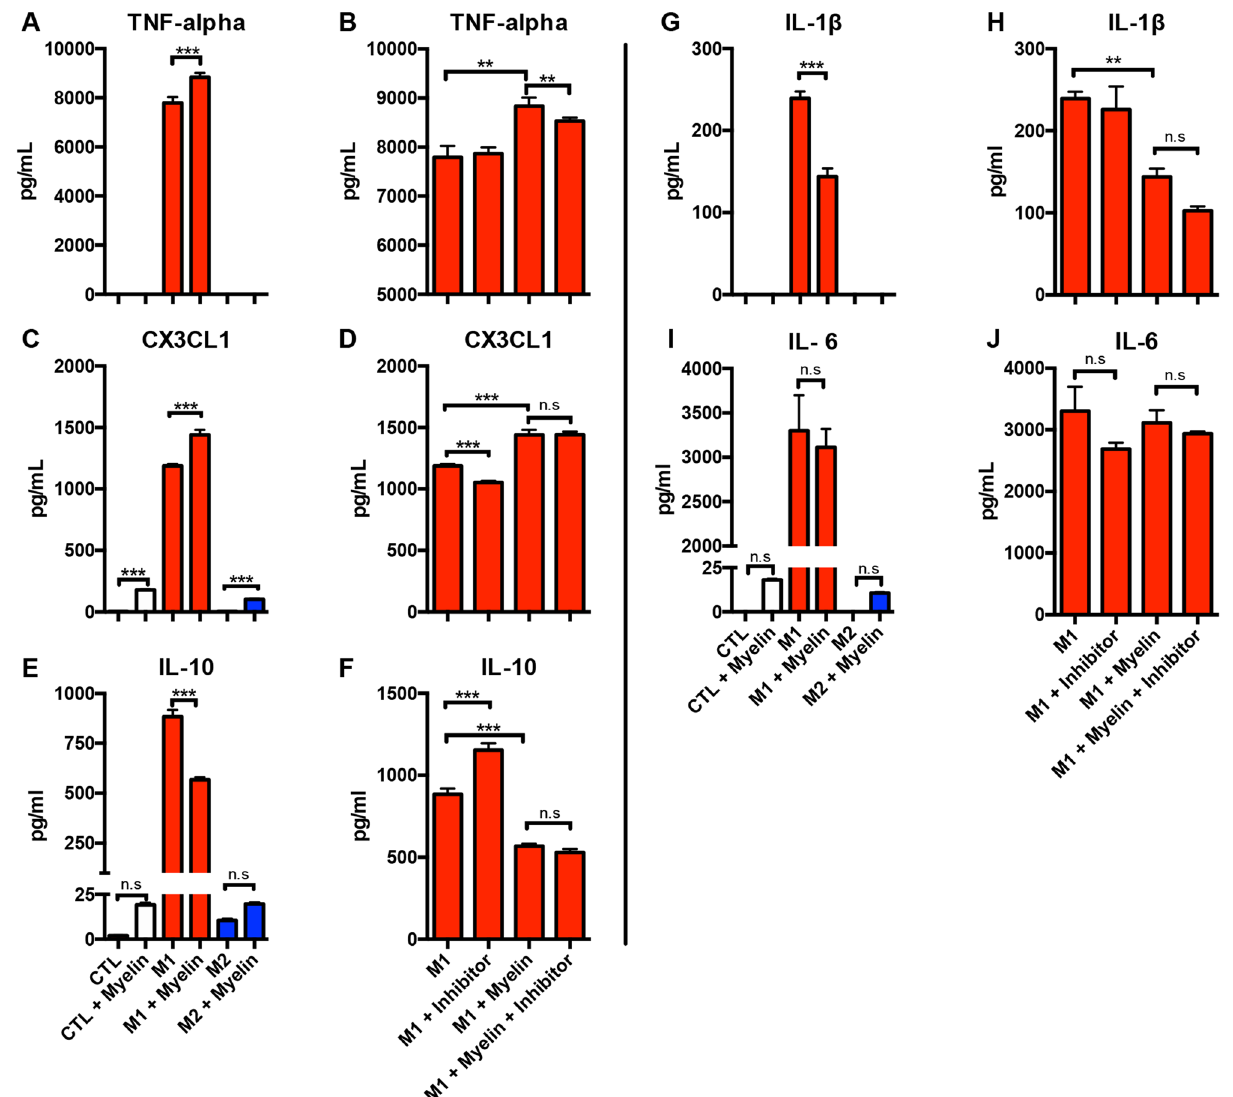
Figure 4. Macrophage cytokine profiles indicate a mixed neuroinflammatory phenotype. Supernatants from treated BMDMs were collected to measure pro- and anti-inflammatory cytokine production in response to phenotype, myelin stimulation, and cPLA 2 inhibition with PACOCF3. ( A , B ) Myelin significanty increases the production of TNF-alpha in M1 cells, but has no effect on CTL and M2 cells. cPLA 2 inhibition significantly reduced myelin potentiation of M1 TNF-alpha production. ( C , D ) Myelin increases CX3CL1 in CTL, M1, and M2 cells.